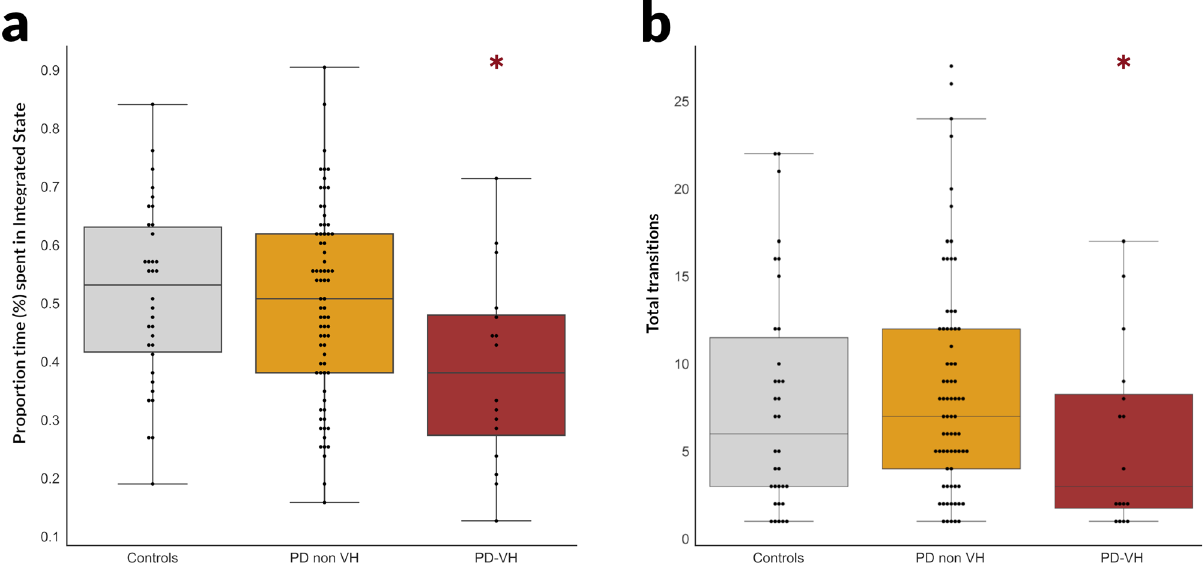
Fig. 2 Altered temporal properties of dynamic functional connectivity in patients with Parkinson ’ s and visual hallucinations. a Percentage of total time spent in the Integrated state. Patients with Parkinson ’ s with visual hallucinations ( n = 16) spent signi fi cantly less time in the Integrated state of dynamic functional connectivity than patients without hallucinations ( n = 75) ( p = 0.032) and controls ( n = 32) ( p = 0.0262) (error bars are 95% con fi dence intervals). b Total number of transitions between states. Patients with Parkinson ’ s and hallucinations ( n = 16) had reduced overall transitions between states than patients without hallucinations ( p = 0.049) (error bars are 95% con fi dence intervals). PD-VH: Parkinson ’ s disease with visual hallucinations, PD-non-VH: Parkinson ’ s disease without